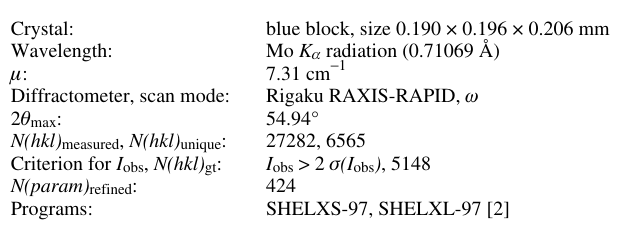
Table 1. Data collection and handling.